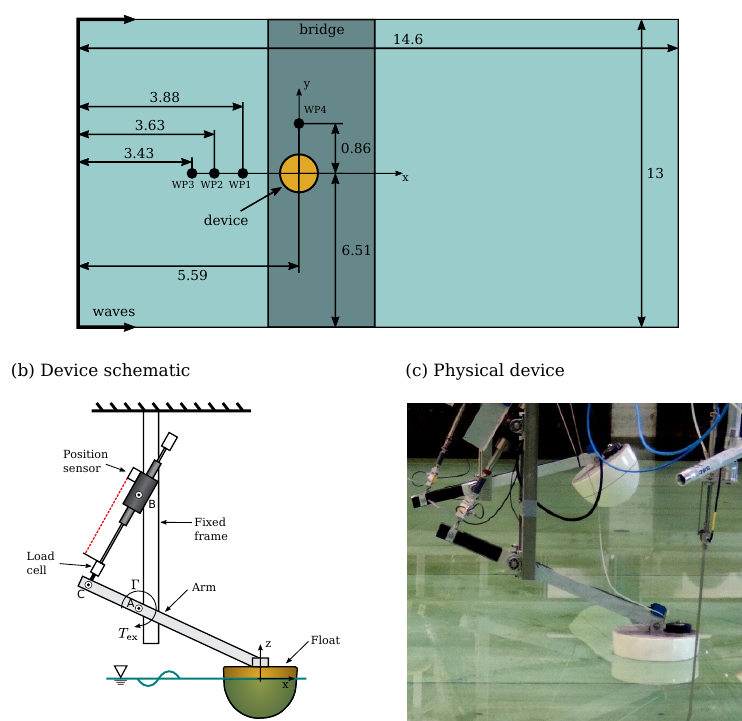
Figure 1. Schematic (not at scale) of the physical wave tank including the wave probe (WP) positions (all dimensions in [m]) ( a ) and the device ( b ). ( c ) shows a photograph of the physical